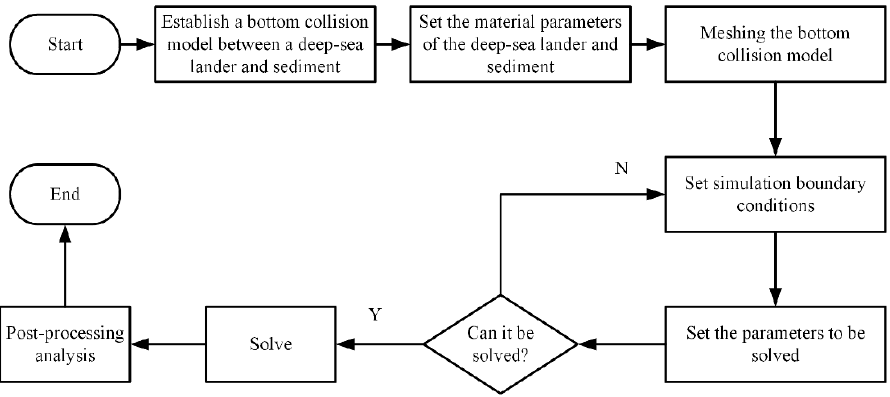
Figure 4. Flow chart of the analysis process.